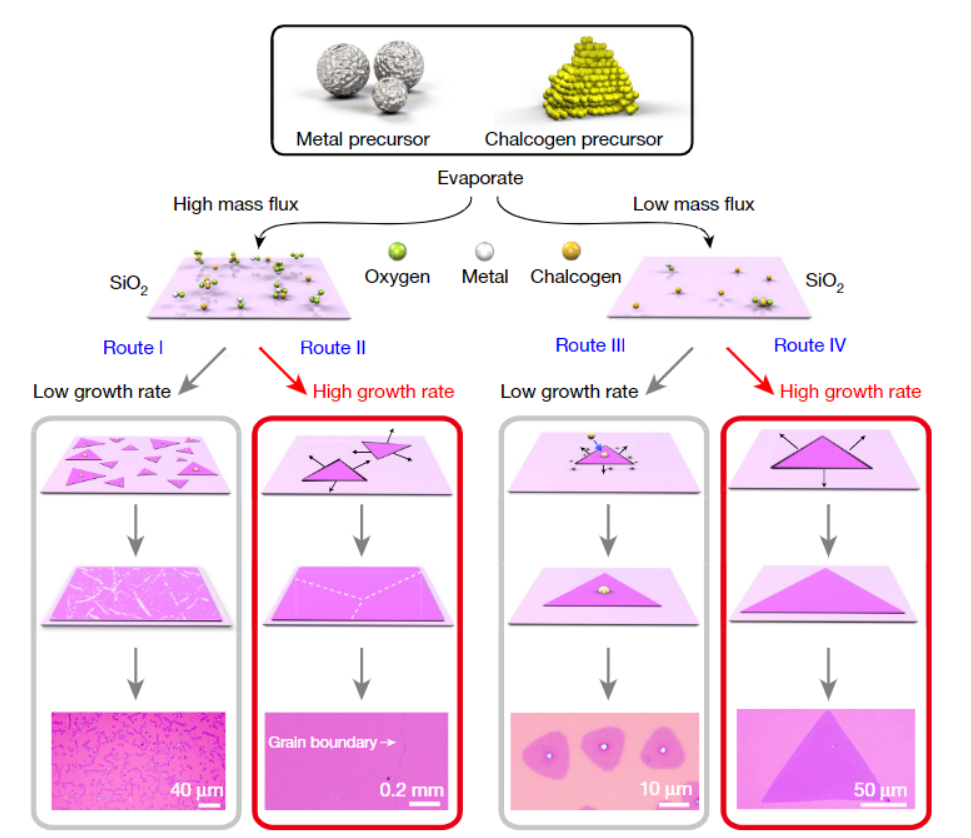
Figure 5. Flow chart of the general growth process for the production of TMDCs by the CVD method. (Reproduced with permission from ref. [82]. Copyright 2018 Nature Publications).